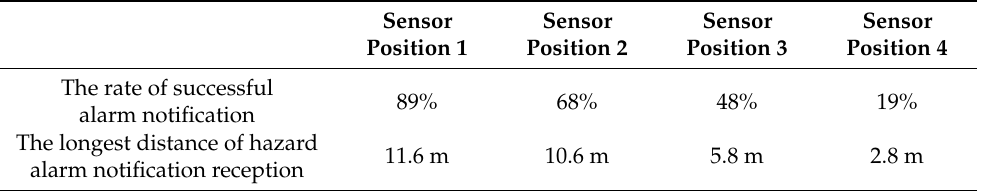
Table 1. Summary of experiment